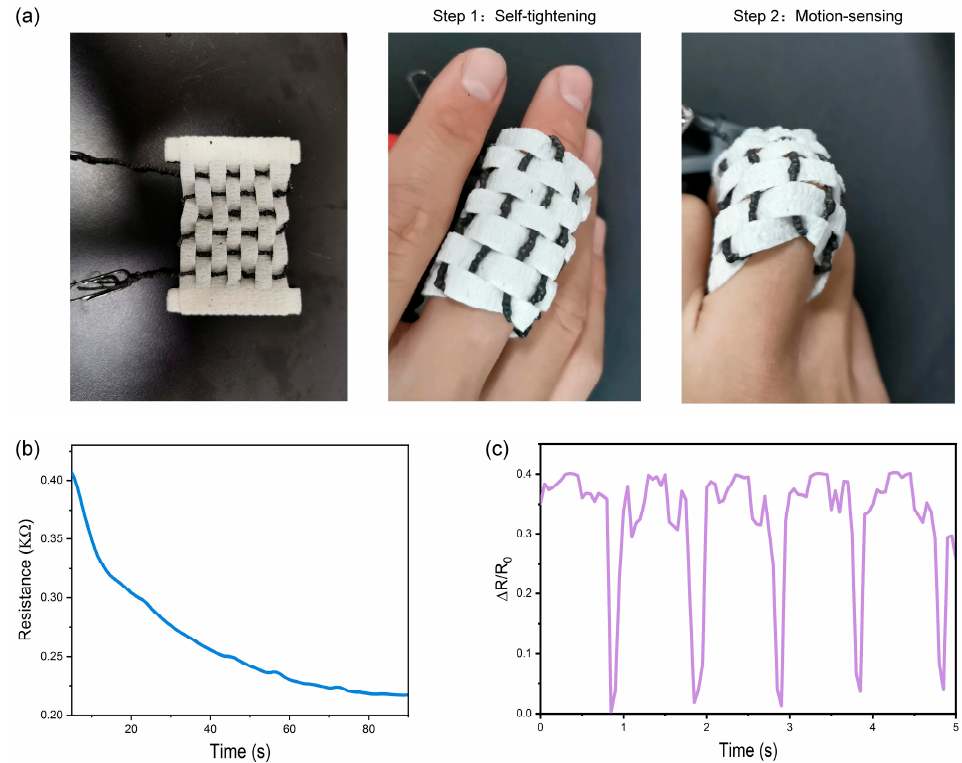
Figure 5. Application demonstrations of the smart textile. ( a ) The picture of the smart textile and the process of self-tightening and motion-sensing; ( b ) The resistance changes of the artificial muscle fiber in the self-tightening process under 20 V; ( c ) The resistance changes from periodic finger flexion.